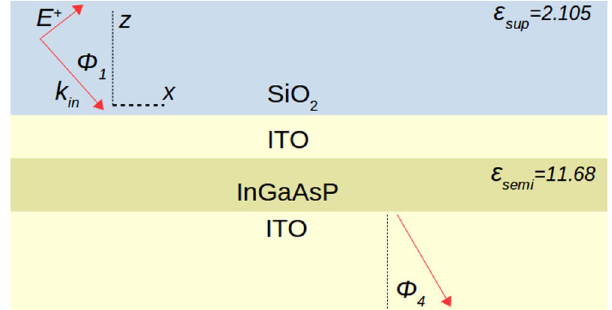
Figure 1. Schematic of the asymmetric metamaterial stack studied which is composed of Silicon Dioxide, Indium Tin Oxide, and Indium Gallium Arsenide Phosphide. Optimized thicknesses for the upper ITO and InGaAsP layers are 8 nm and 20.8 nm respectively. The incoming field, which is described later in the Methods section, is TM-polarized with an incident angle ϕ 1